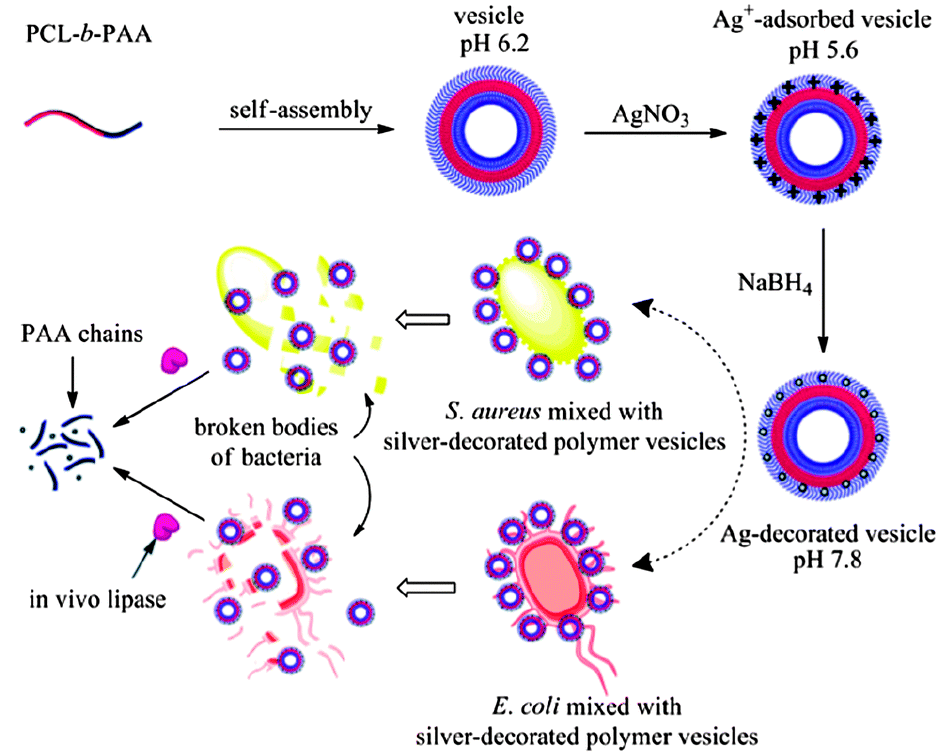
Figure 2. Schematic illustration of AgNPs-decorated biodegradable antibacterial polymer vesicles [50] (Reprinted with permission from [50]). cles [50] (Reprinted with permission from